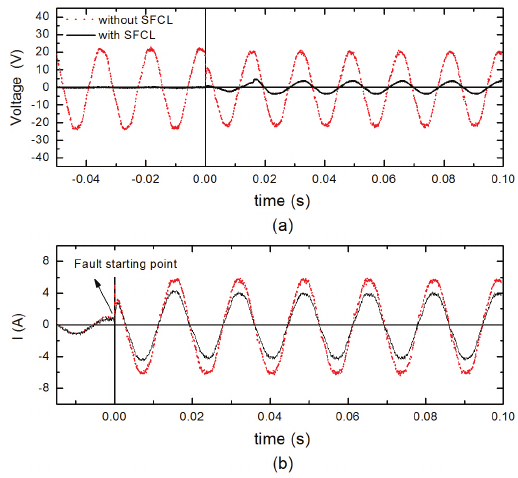
Figure 2. First ac test of the device for a fault duration time of five cycles. Here was used Hg,Re-1223 sample. The resistances were R = 20.0 Ω and R = 4.0 Ω . 1 2